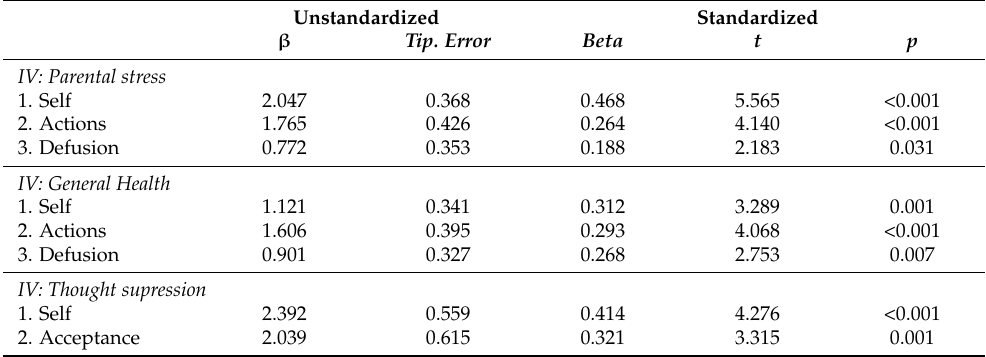
Table 6. Multiple stepwise regression analysis for parental stress, general health and thoughts suppression and parental psychological flexibility as dependent